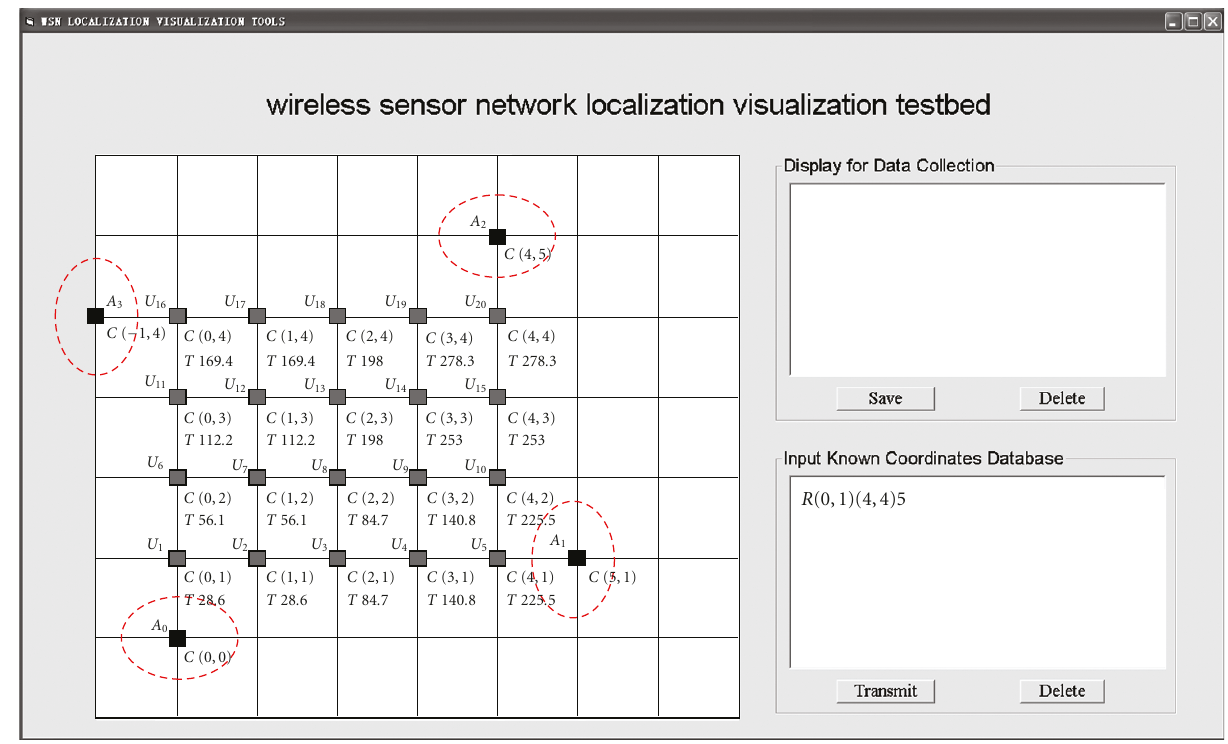
Figure 17: Localization schematic diagram about multianchor nodes.